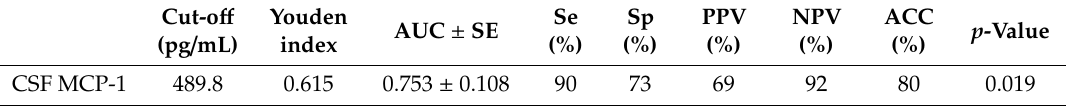
Table 8. The optimal cut-o ff point of CSF MCP-1 to predict the number of